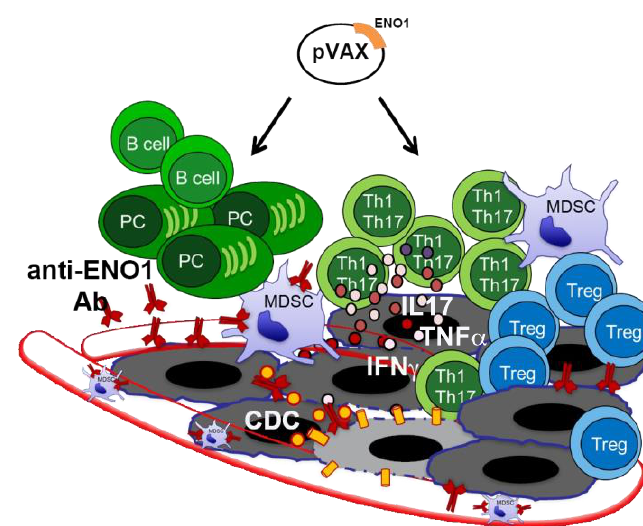
Figure 1. Alpha-enolase (ENO1) DNA vaccination effects in pancreatic ductal adenocarcinoma (PDA) mouse model. Cartoon shows the multiple effects of ENO1 DNA vaccination on the antitumor immune response (black arrows): activation of B cells producing anti-ENO1 antibodies (Ab) that affect tumor cells and myeloid-derived suppressor cells (MDSCs) invasion and endothelial adhesion (vessels are shown as transparent red tubes). Moreover, vaccine induces complement-dependent cytotoxicity (CDC) of tumor cells (grey cells) and T cells, specially Th1/Th17 cells that release IL17, TNFα and IFNγ cytokines. Yellow circles and cylinders indicate the complement system and the membrane attack complex, respectively, involved in the CDC. Circles represent cytokines; plasma cell (PC).